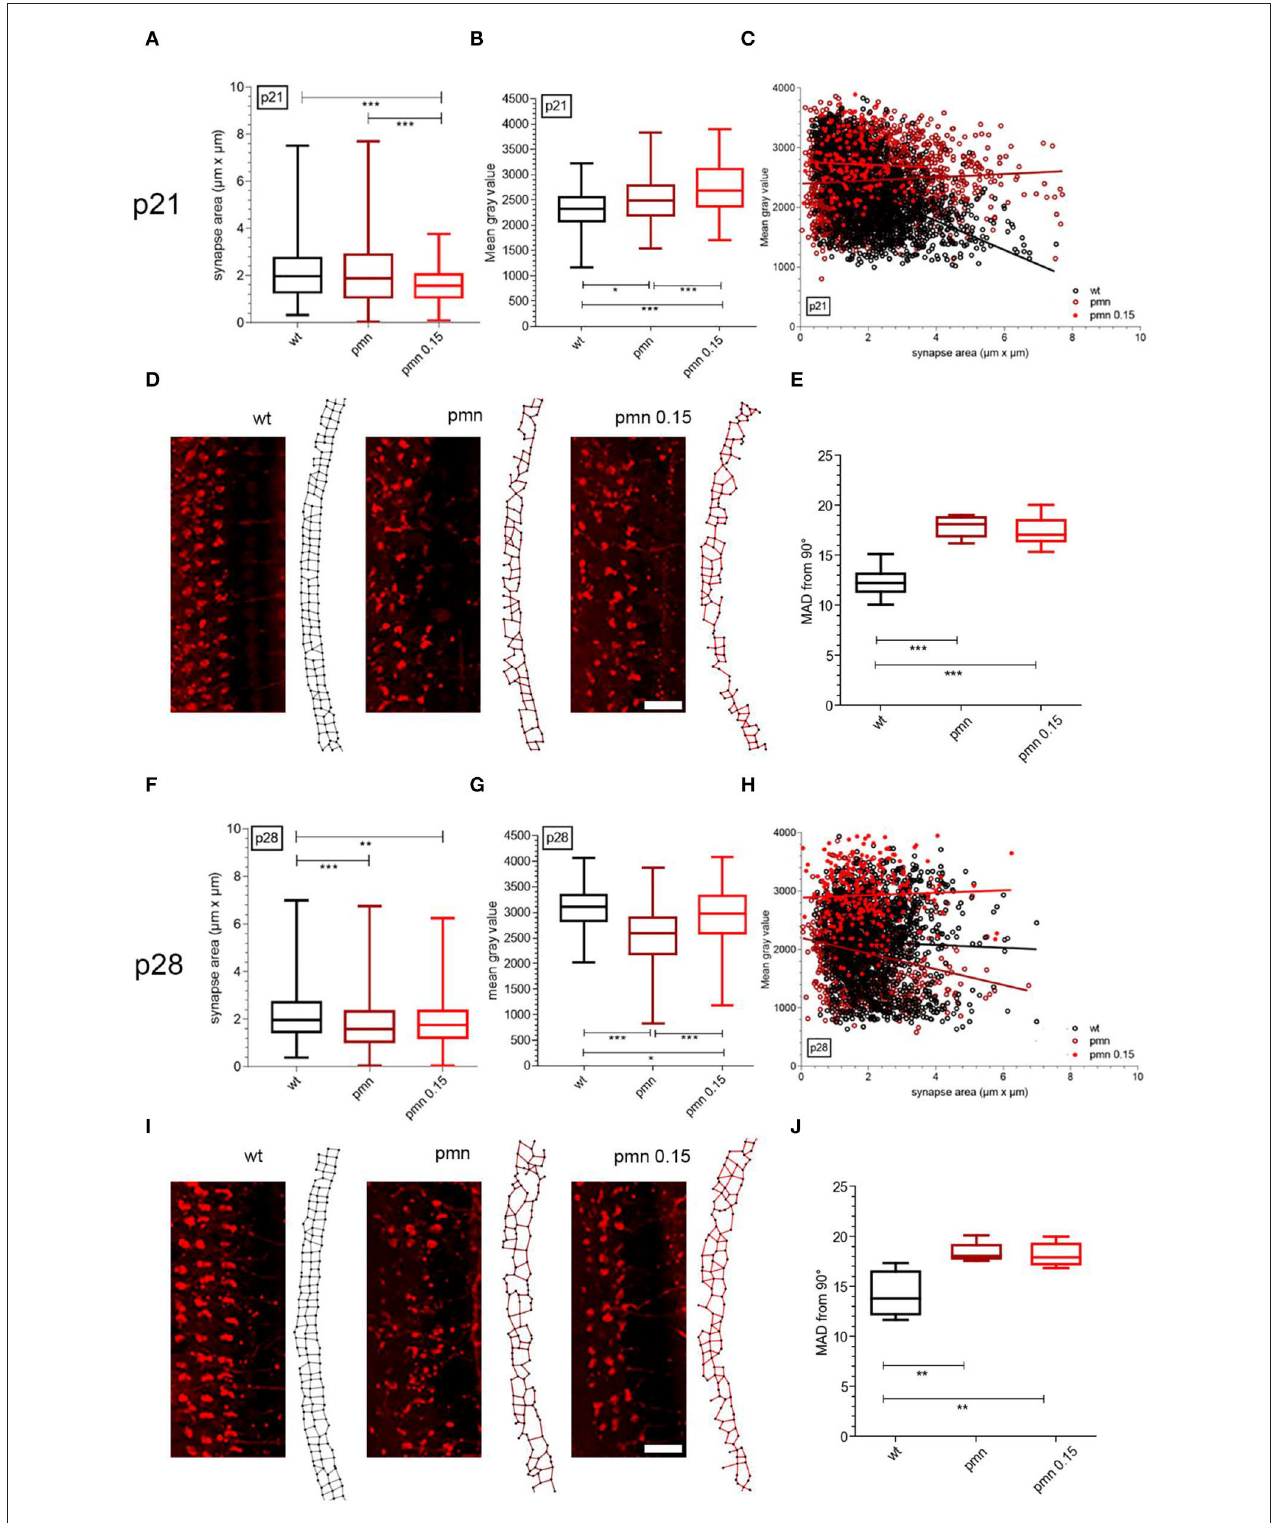
FIGURE 1 | Evaluation of cholinergic synapses of MOC fibers at p21 and p28 with peg-IGF-1 treatment. (A) Analysis of the synapse area and (B) the mean gray value demonstrated a significantly decreased area and an increased mean gray value of treated PMN animals compared to untreated PMN littermates and wildtype